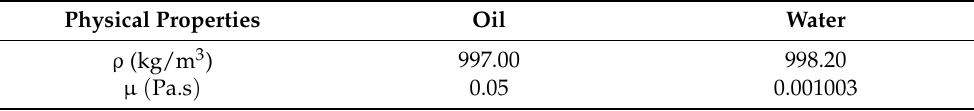
Table 5. Thermo-physical properties of oil and